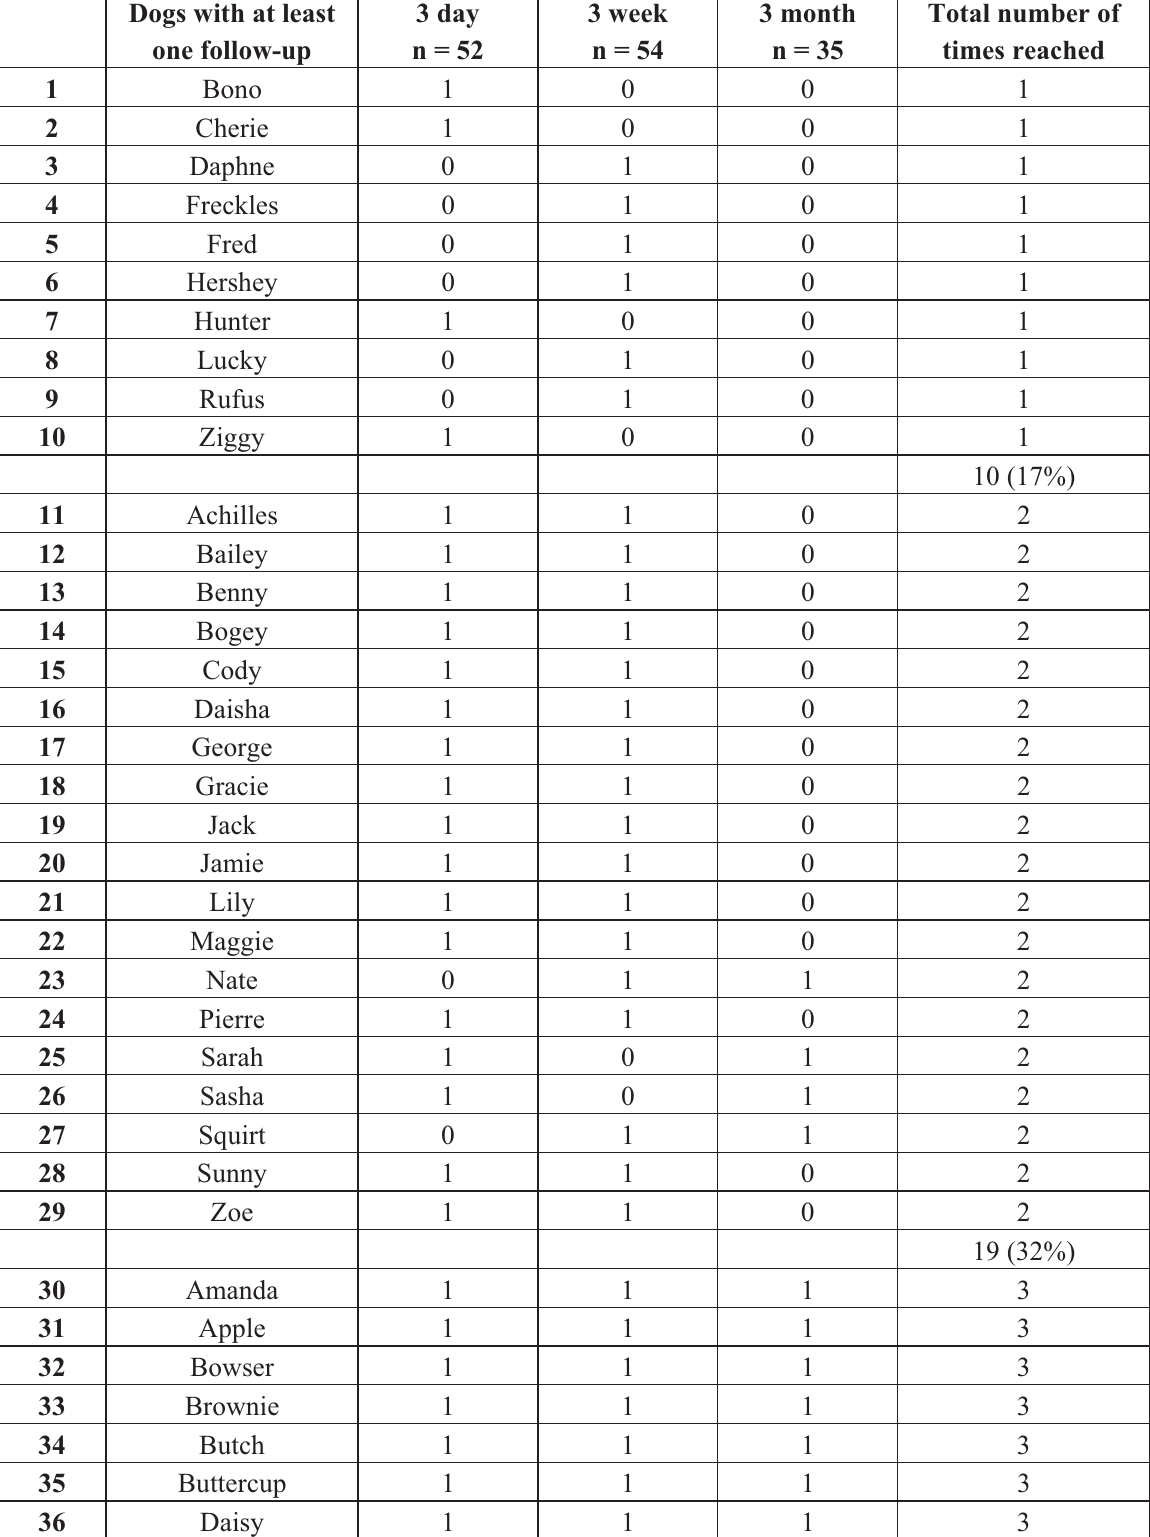
Table 2. All dogs that had at least one response to a follow-up call post-adoption (n = 60). Dogs are organized by number of times they were reached over all three attempts and do not include the six dogs who were